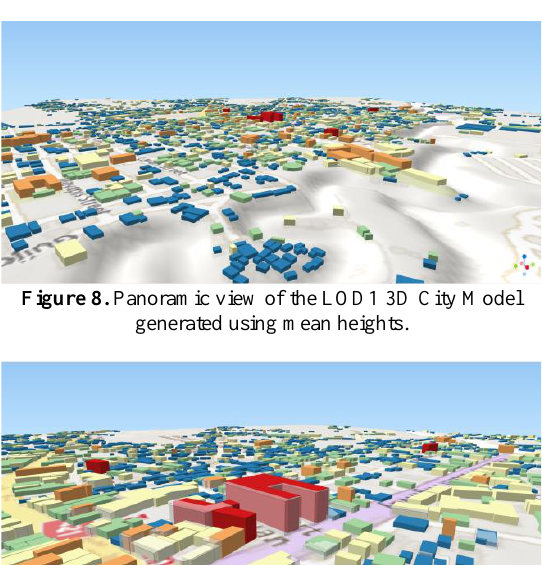
Figure 7. Areas showing buildings under Case 1 and Case 4.